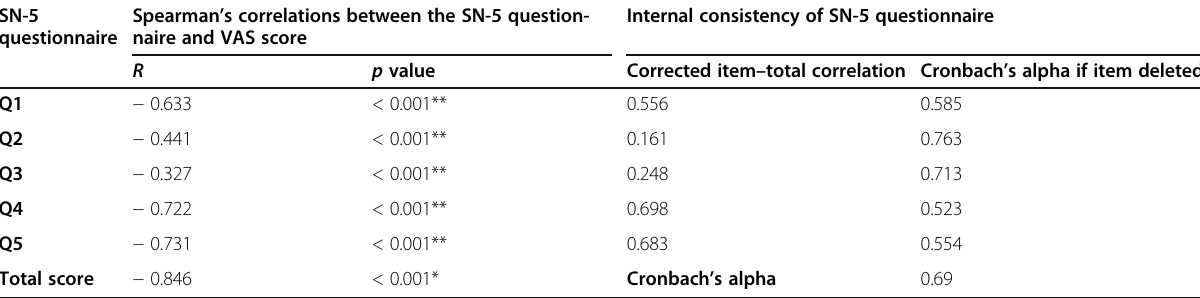
Table 2 Construct validity and internal consistency of the SN-5 questionnaire SN-5 Spearman ’ s correlations between the SN-5 question- Internal consistency of SN-5 questionnaire questionnaire naire and VAS score p value